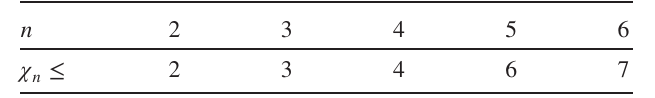
algorithm for computing low-rank decompositions of j H ⊗ n